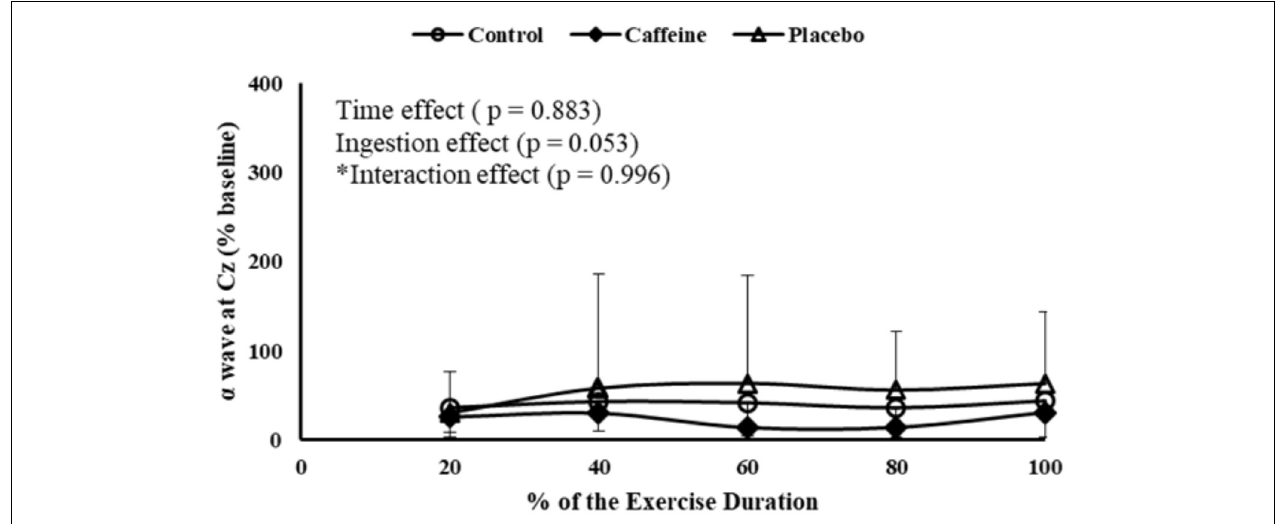
FIGURE 3 | EEG α wave measured at primary motor cortex during MIT in control, caffeine and placebo (perceived as caffeine). Main effects of time and ingestion and time by ingestion interaction effects were reported in the figure. Values are mean ( ±